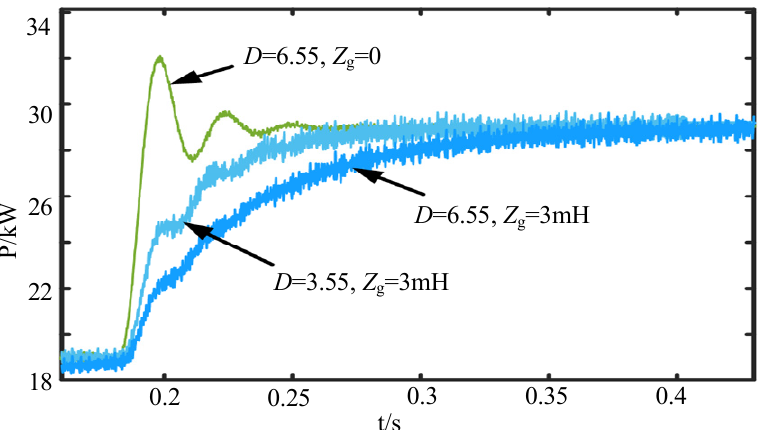
Figure 14. Diagram of dynamic adjustment of damping coefficient.